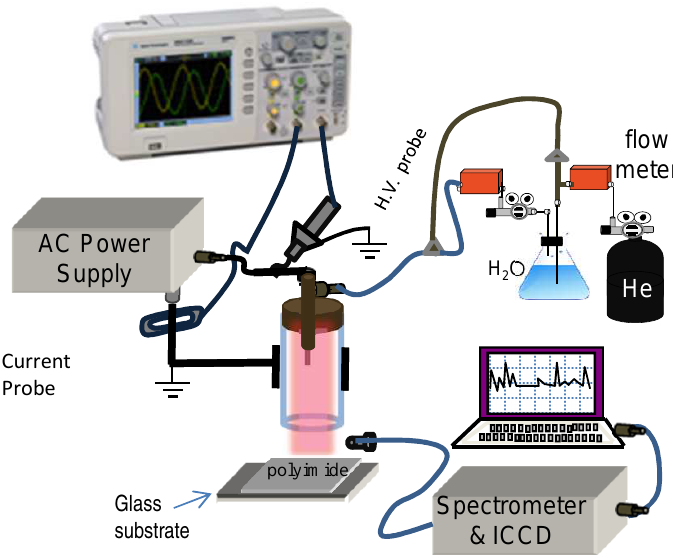
Figure 1. Schematic diagram of the experimental set-up for He-H 2 O atmospheric pressure plasma processing.